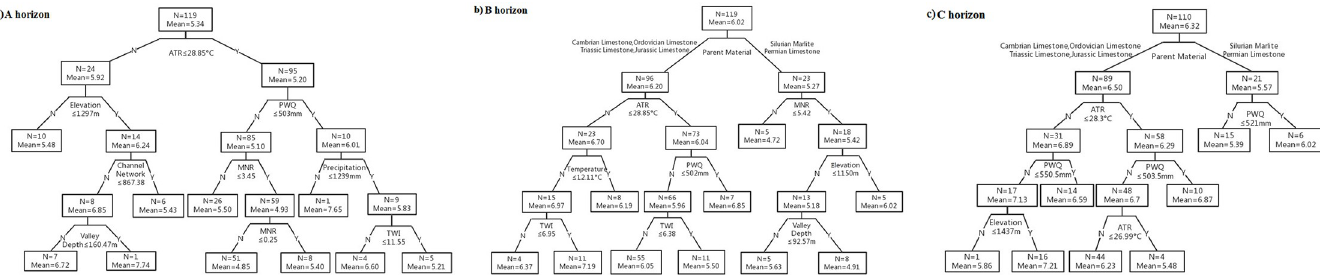
Fig 4. CART analysis for each horizon: a) A horizon, b) B horizon, c) C horizon.